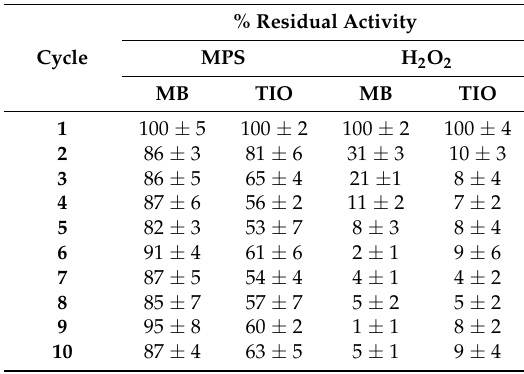
Table 2. Multicycle use of FSG-Pyr/FeTPFPP in the presence of both MPS and hydrogen peroxide at pH 3.